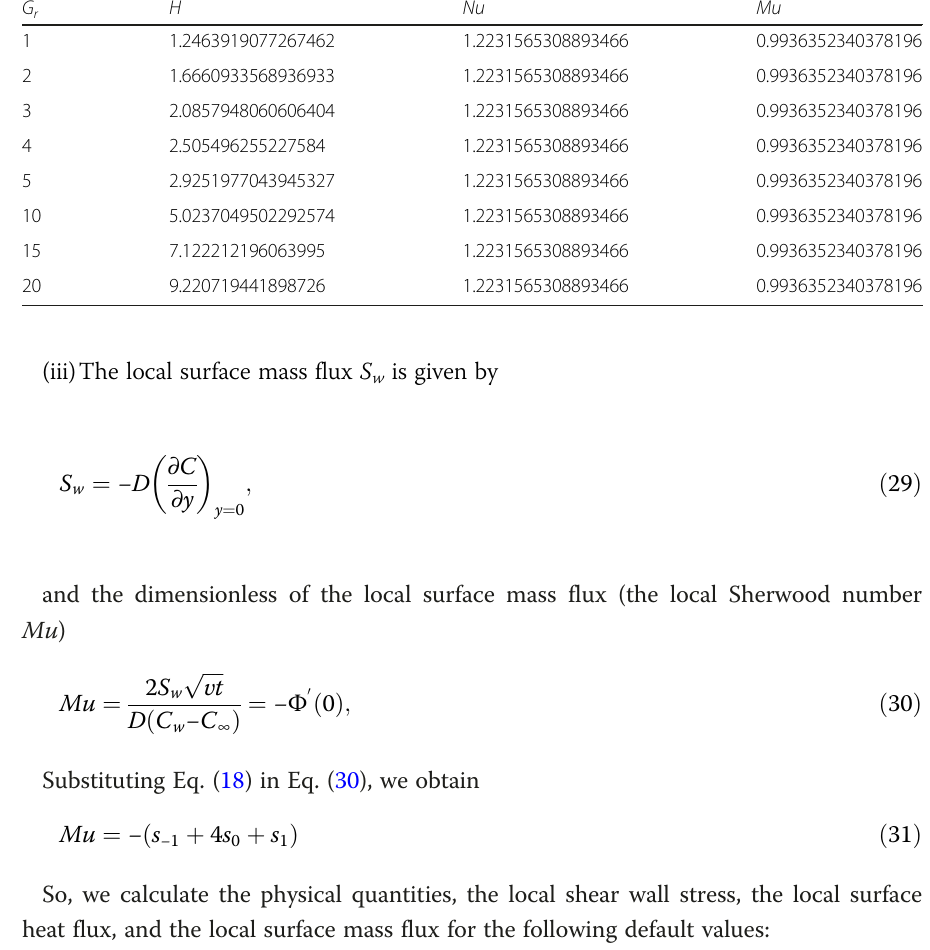
Table 2 Values of skin friction ( H ), Nusselt number ( Nu ), and Sherwood number ( Mu ) for different values of G r G H Nu Mu r